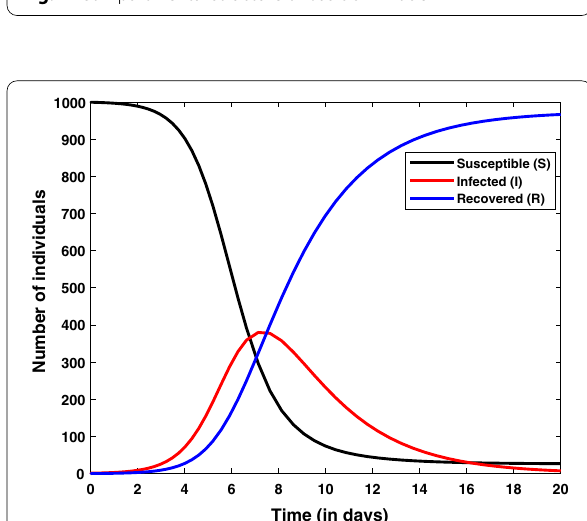
Fig. 2 Numerical solution of basic SIR model. Model is simulated for initial values S = 1000, I = 1, R = 0 and parameter values β = 1.5 × 10 − 3, γ = 0.4